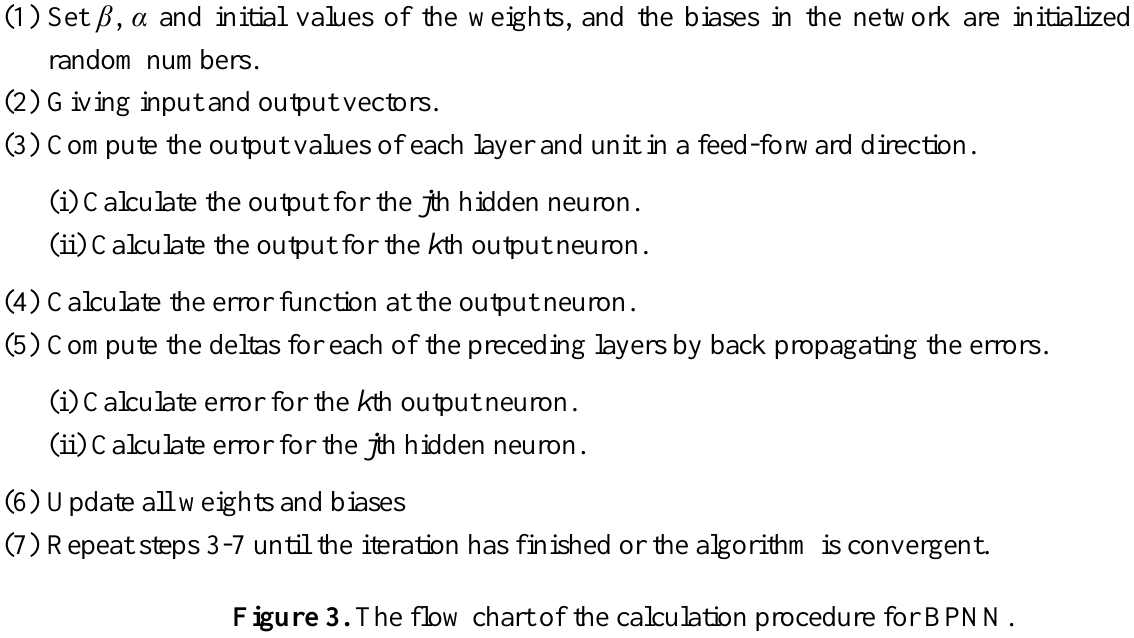
Figure 3. The flow chart of the calculation procedure for